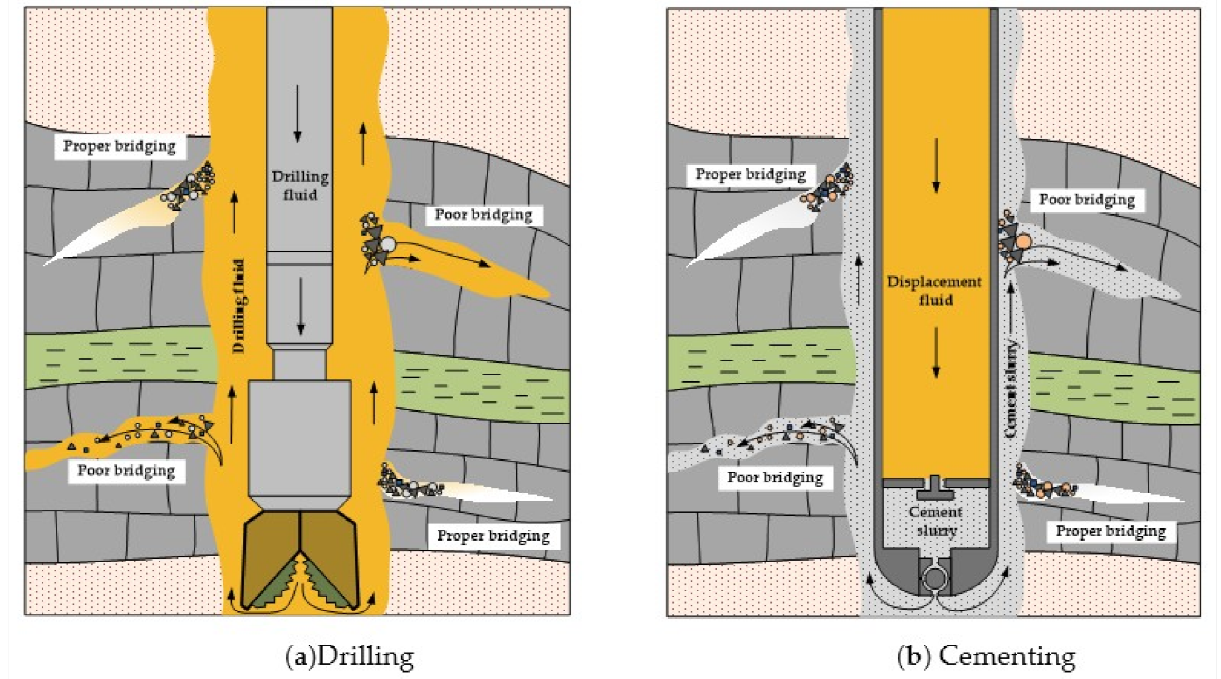
Figure 4. Illustration of lost circulation during drilling ( a ) and cementing ( b